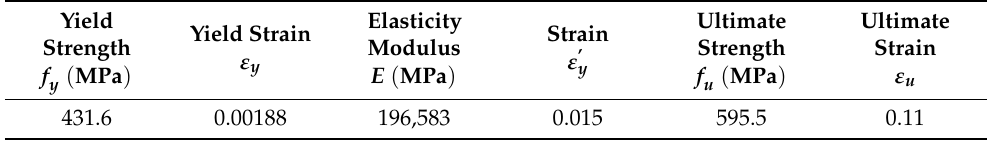
Figure 11. Material Model. ( a ) Material model of Q355 steel, ( b ) Material model of high-strength bolt. Table 6. Mechanical property parameters of steel material Q355.